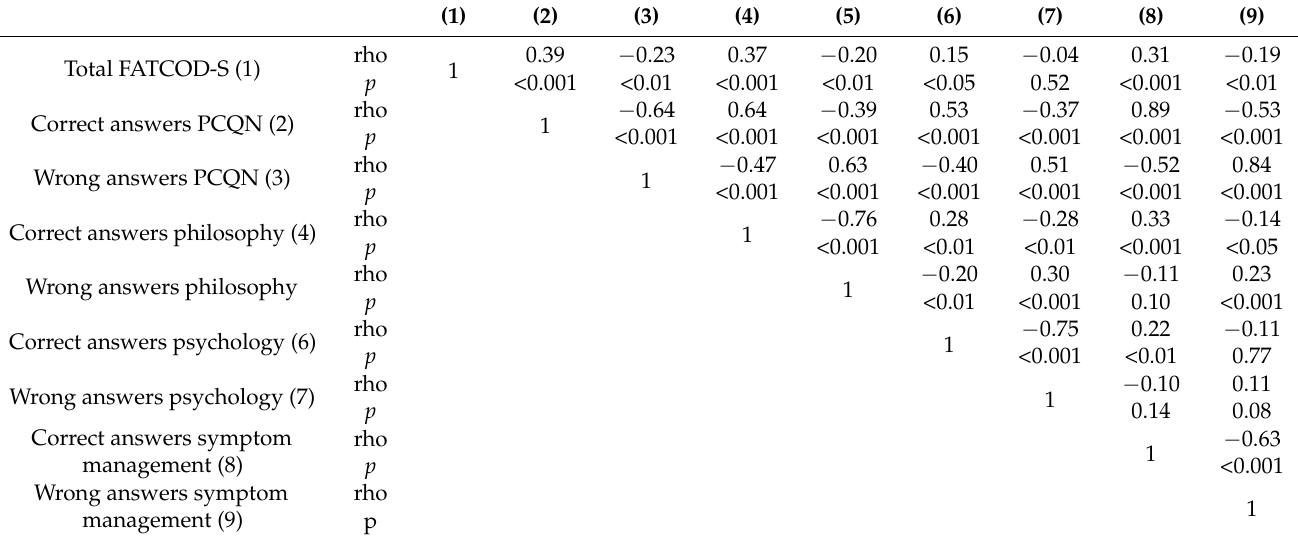
Table 6. Correlations among instruments.